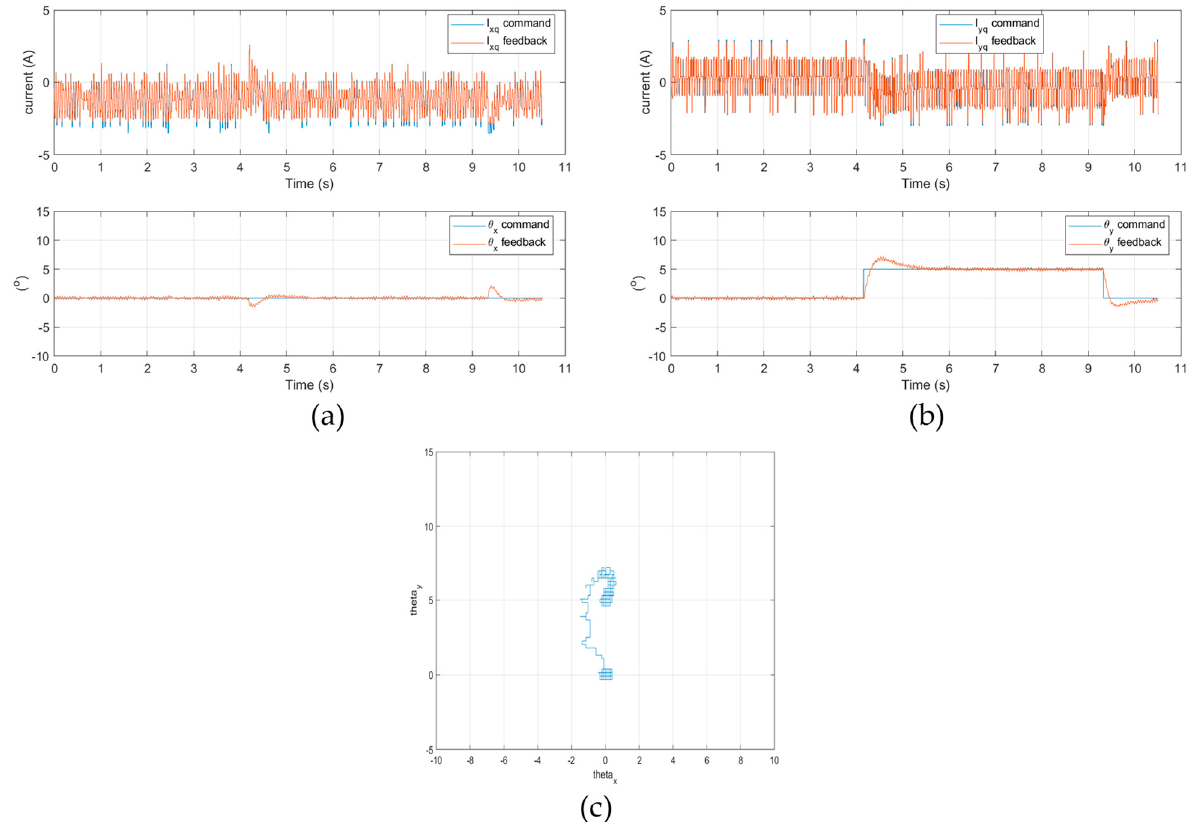
Figure 9. The experiment results for the position control of the HMDOF motor at the rotating motor speed of 1120 RPM (with feedforward compensator): ( a ) the control results of the roll motor; ( b ) the control results of the pitch motor; ( c ) the trajectory of the tilting motors on the θ x − θ y plane. Position control was performed when the position command in the roll direction was set to 0° and the pitch angle command was changed to 0° ➔ 5° ➔ 0°. Figures 8 and 9 show the q-axis current and the angle data of the roll and pitch motors, respectively.